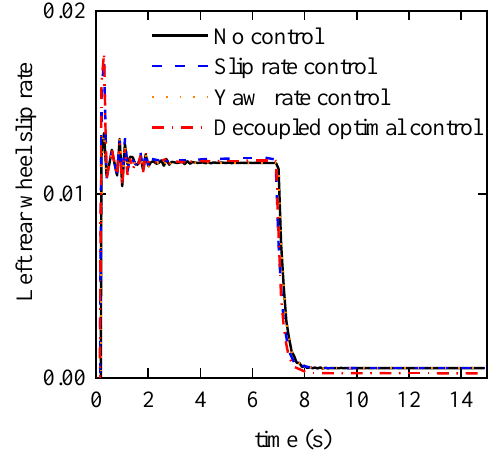
Figure 14. Left rear wheel slip rate.